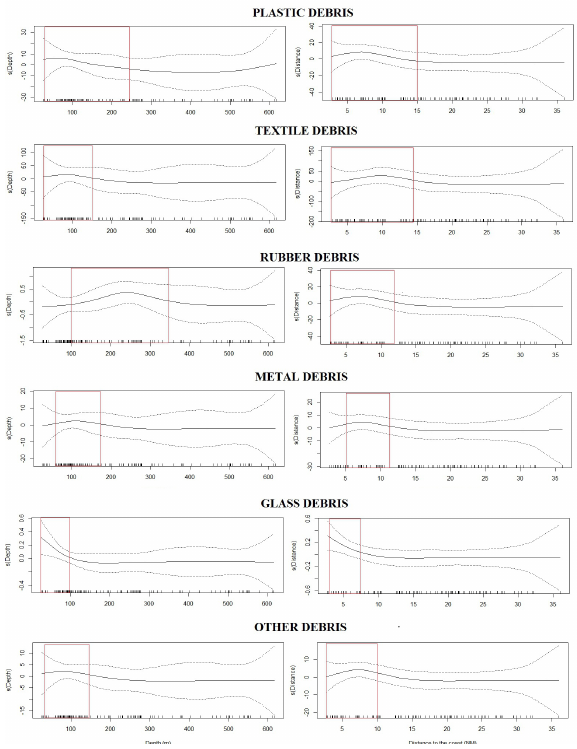
Figure 8. Analysis of Non-linear relationships between the average density of different categories collected in 2018 and the Figure 7. Analysis of relationships between the average density depth / the distance to the coastline using the Generalized of different categories of collected SMD in 2015 and the depth / Additive Model the distance to the coastline using the generalized additive model (GAM).